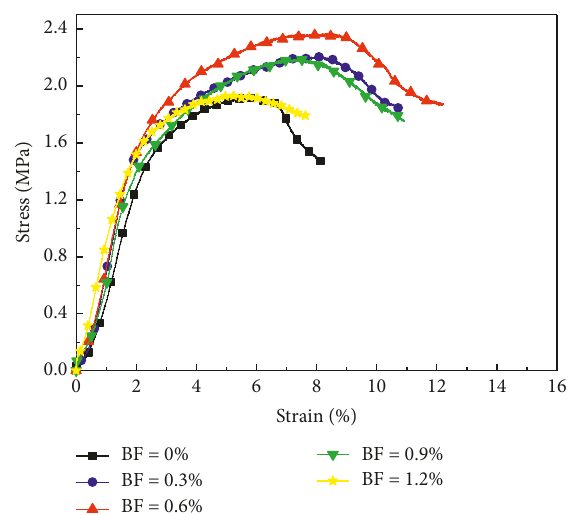
Figure 10: Static stress-strain curves of basalt fiber-reinforced cement-fly ash-stabilized soil.